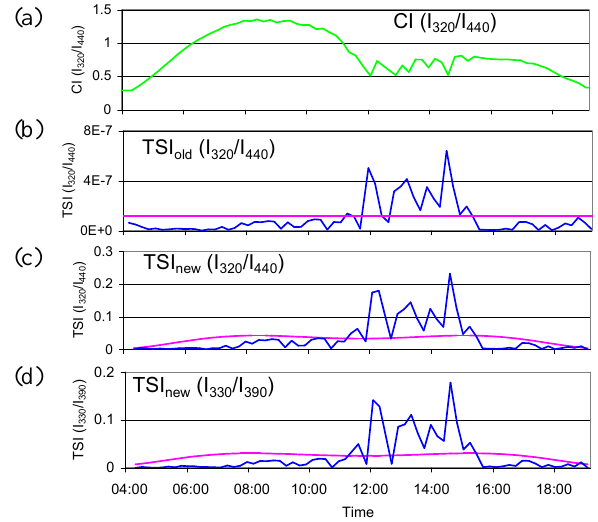
Figure 11. (a) Measured normalised CI (a) for 24 June 2009. (b) Normalised TSI according to the original algorithm. Here a con- stant threshold value was used. (c, d) New TSI as used in this study without normalisation and explicit consideration of the time (Eq. 7). The threshold values for the new TSI depend on the